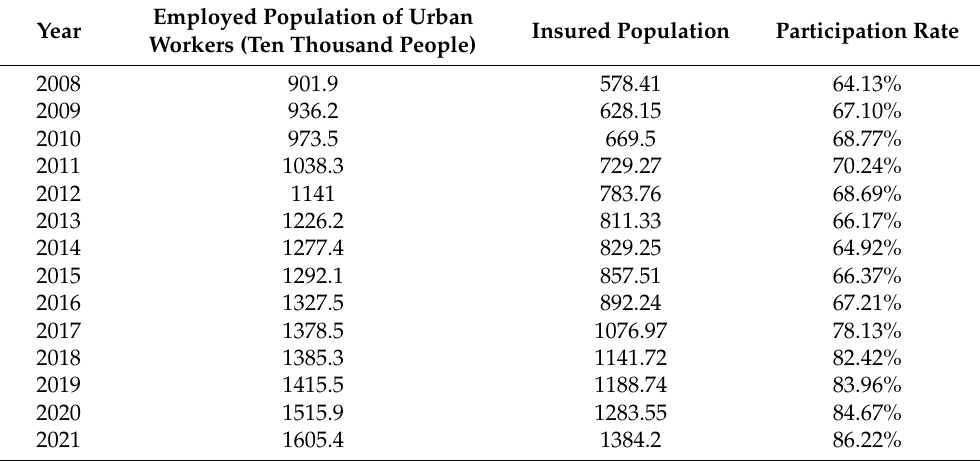
Table 2. Anhui Province pension participation rate over the years.